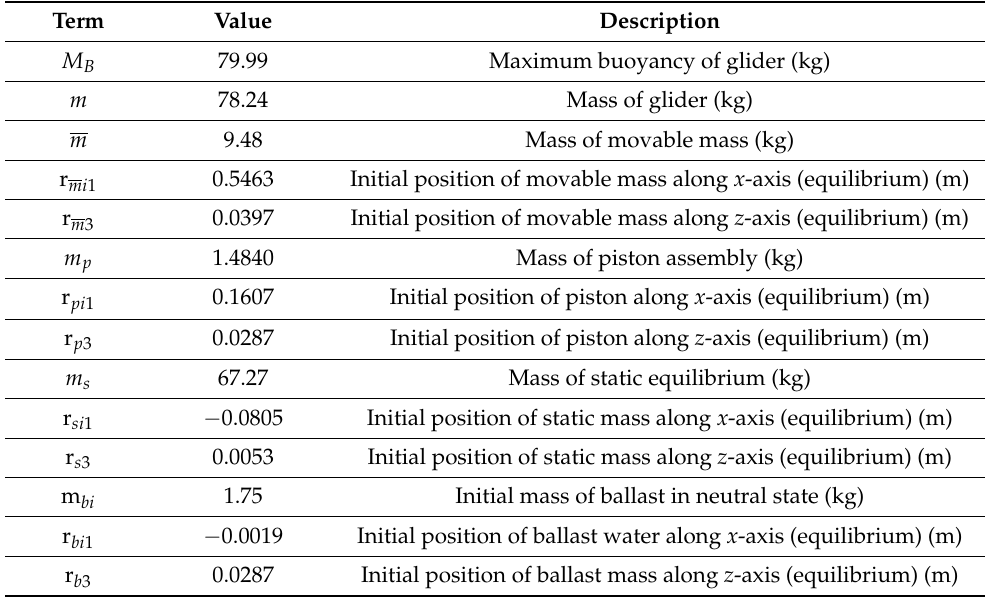
Table 1. Parameters of the glider (fresh